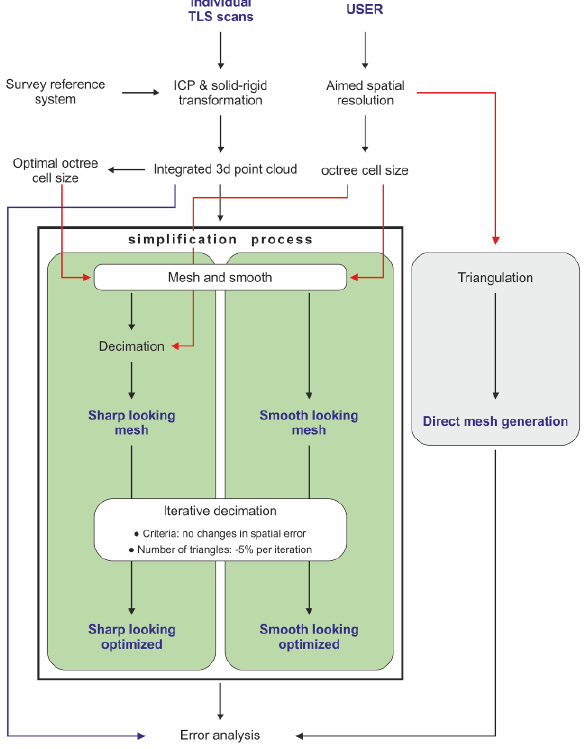
Figure 5. The proposed simplification pipeline (bolded area) for the post-processing of the surveyed